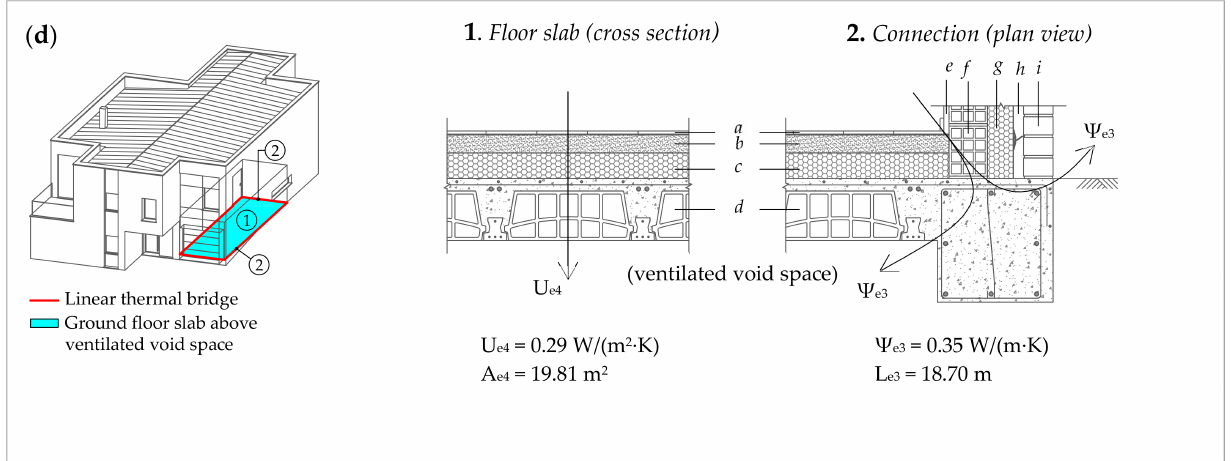
Figure 8. Characterization of the thermal envelope of Garage 2: ( a ) the horizontal slab of the